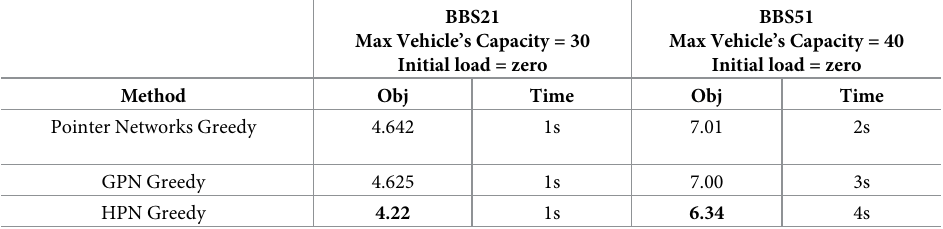
Table 2. Our result on BBS21 and BBS51, obj denotes for the total tour length and the Time denotes for the time for evaluation the result averaged over 10k